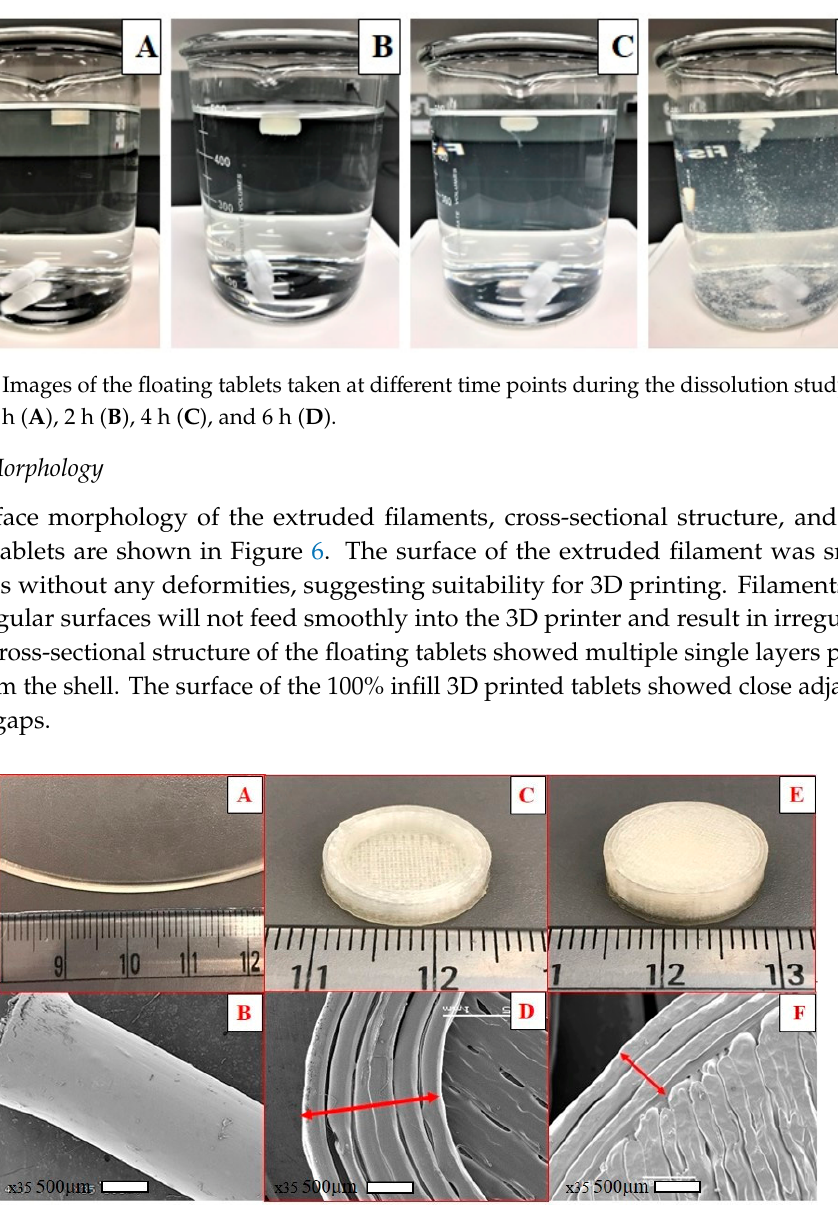
Figure 6. Digital images and representative SEM images of the hot-melt extrusion (HME) filament ( A , B ), the cross-sectional structure of the floating tablet showing shell ( C , D ), and surface morphology of a 100% infill 3D printed tablet ( E , F ).